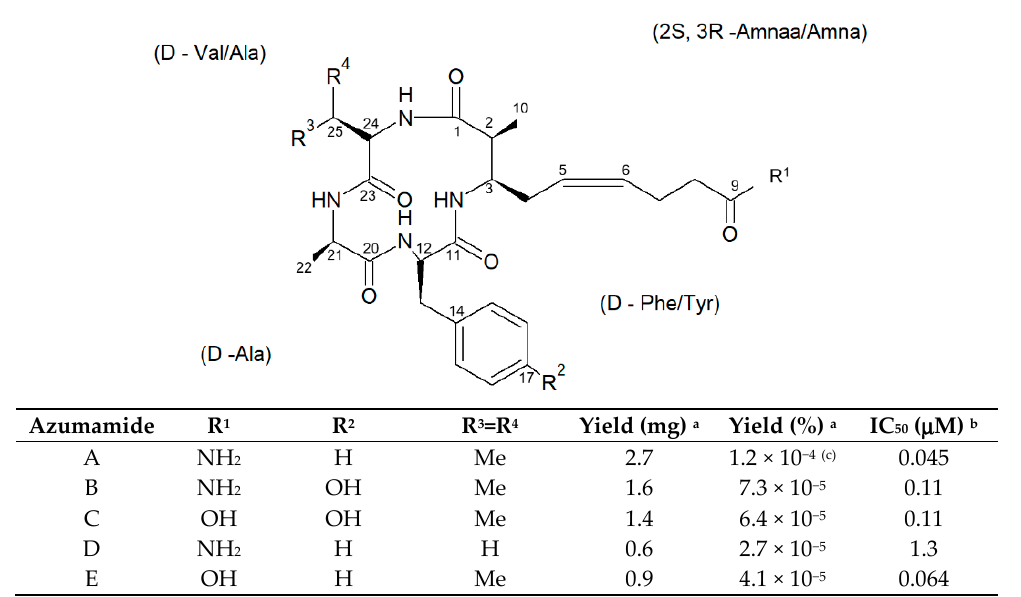
Figure 13. Structures of azumamides A-E. (a) Yield of azumamide isolated by extraction from a marine sponge. (b) Against the crude enzymes extracted from K562 cells. (c) Yield based on wet weight [65].